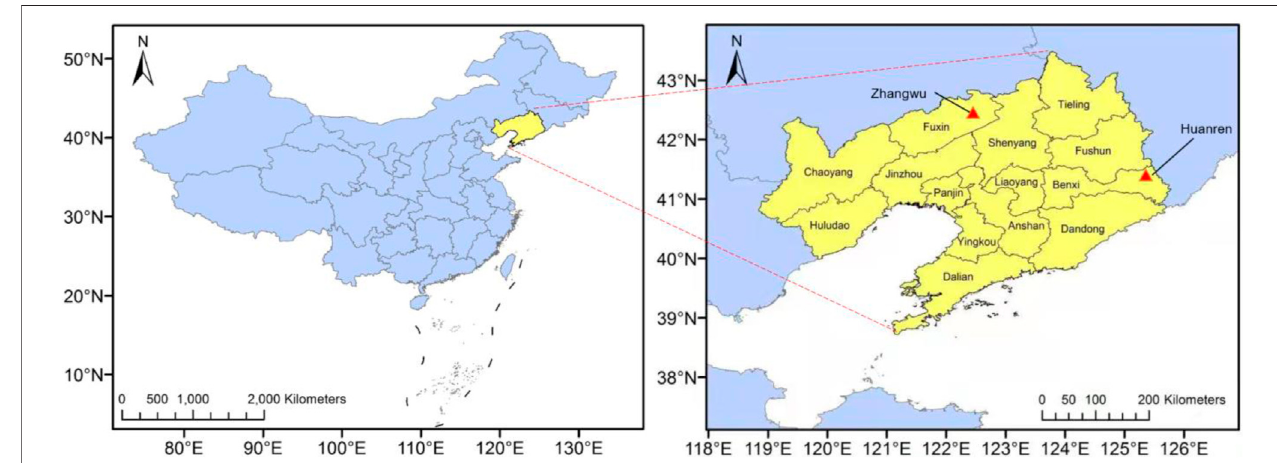
FIGURE 1 | Location and cities in Liaoning province, China.